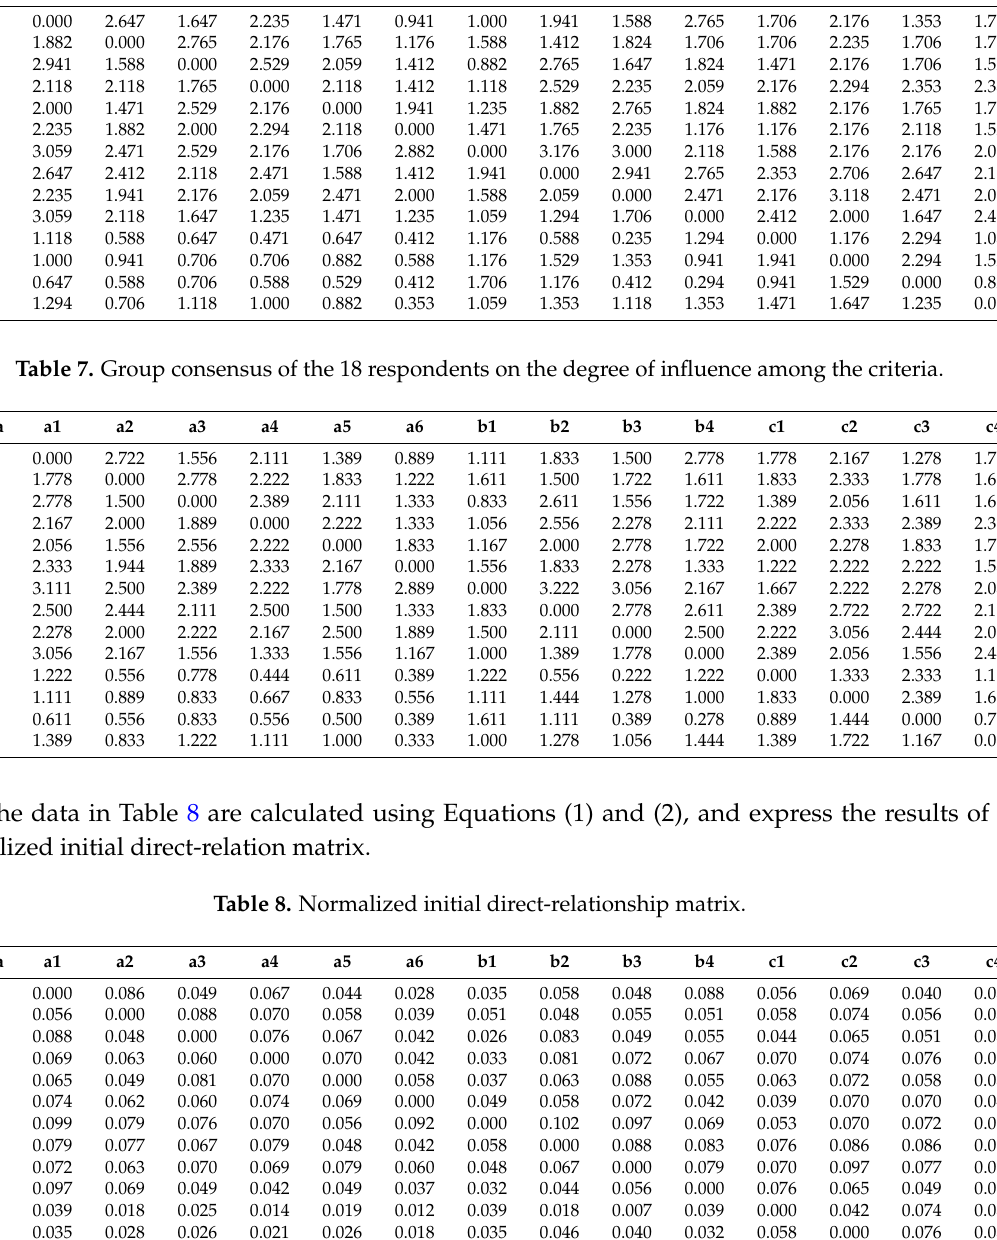
Table 6. Group consensus of the 17 respondents on the degree of influence among the criteria. Criteria